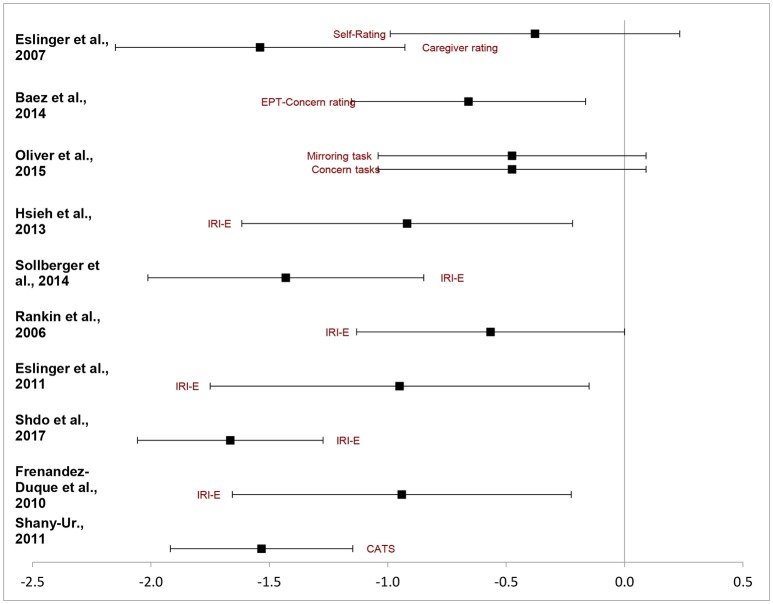
Random effect sizes. (2, 22, 24, 27, 30, 43–47).